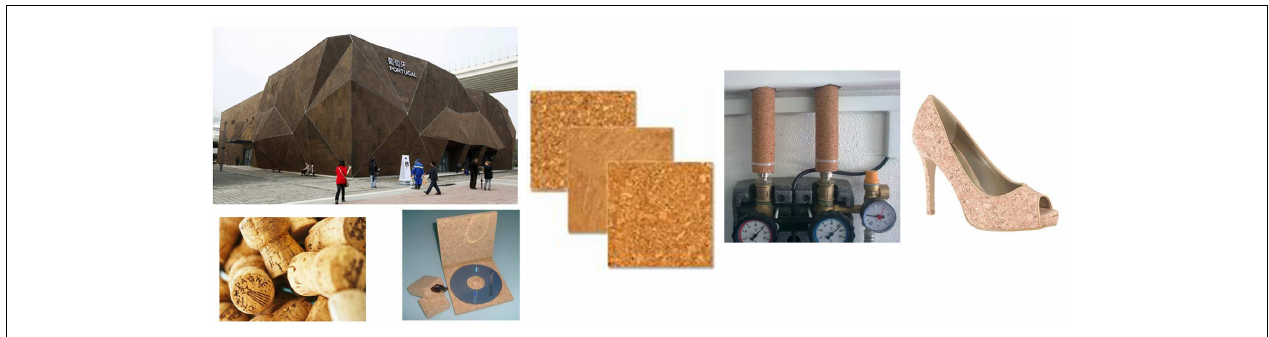
FIGURE 5 | Examples of applications for cork agglomerates